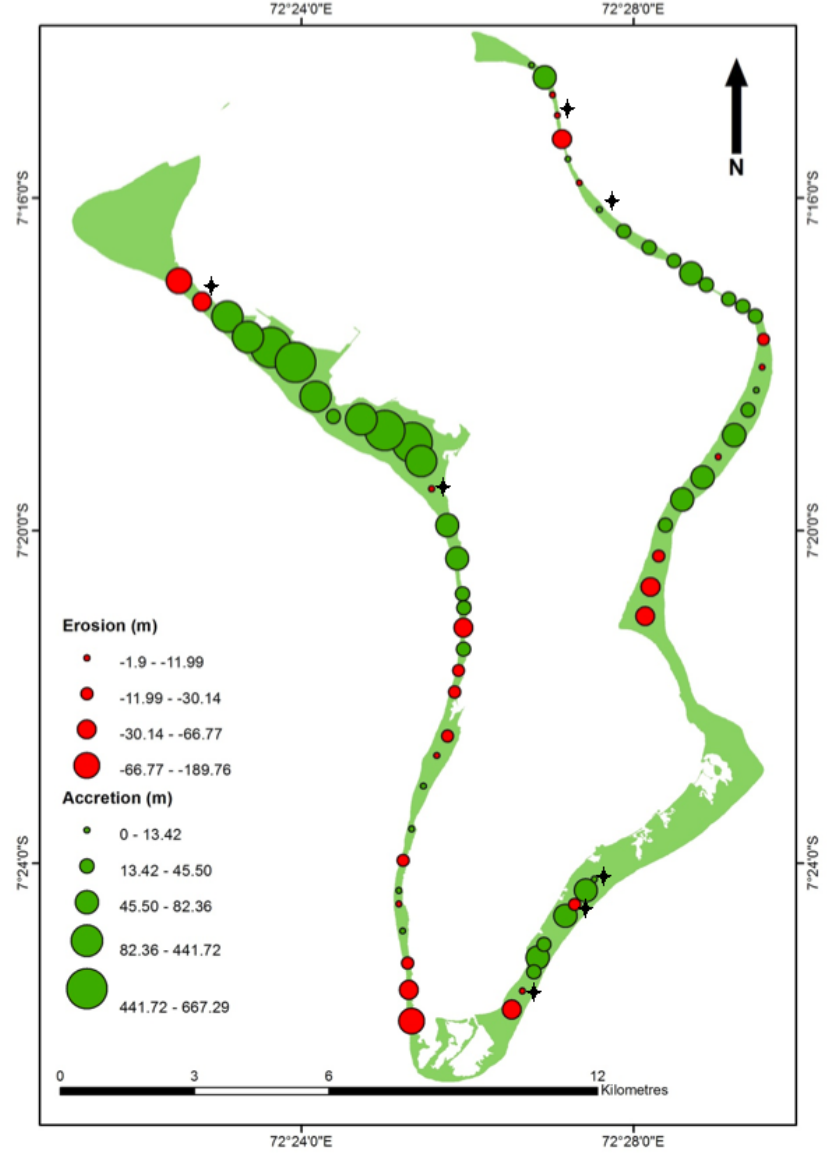
Figure 4. Change in rim width (m) between Stoddart’s 1967 survey & the 2005 IKONOS images. Black crosses denote points where the estimated change fell within the methodological error